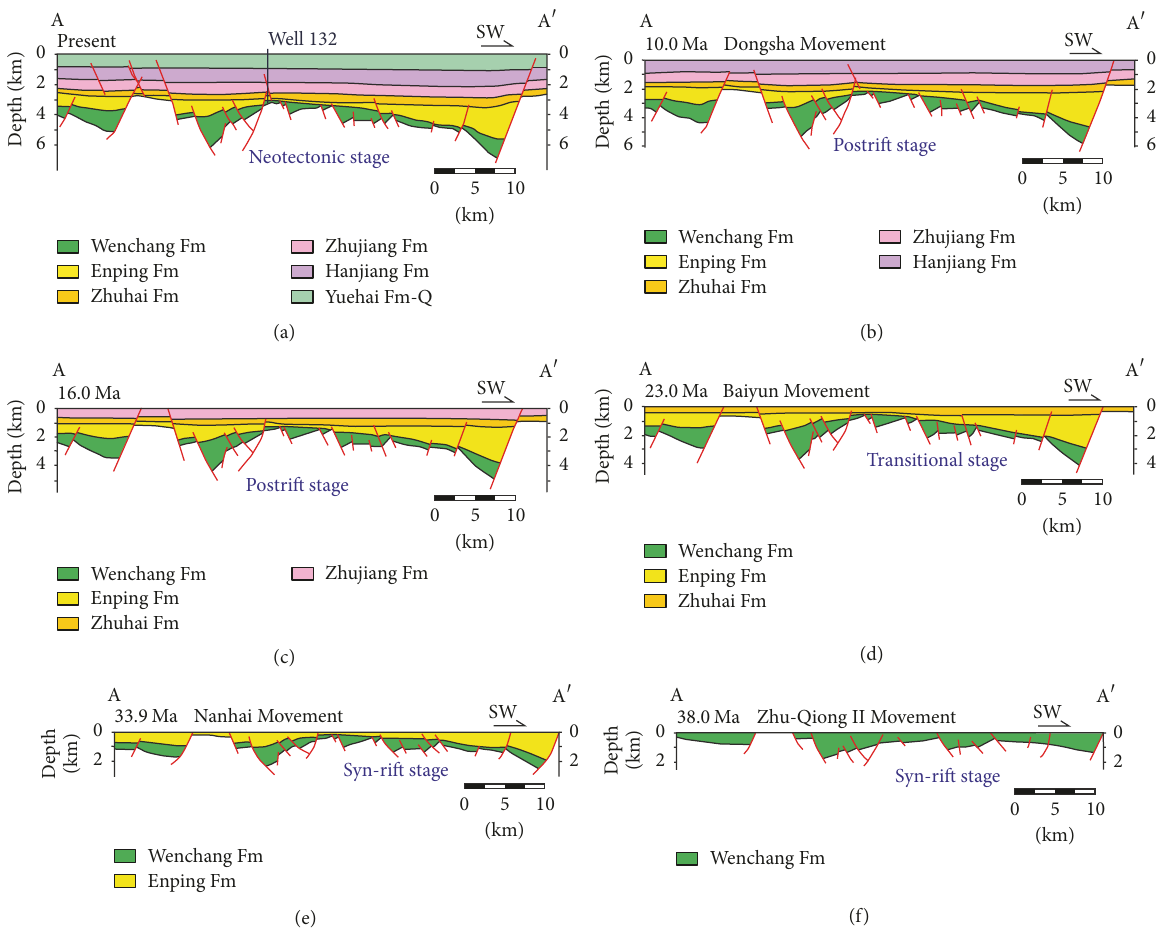
Figure 13: Tectonic evolution of the Huizhou Sag during the Paleogene rift stage and Neogene postrift stage (the locations of the profile AA 󸀠